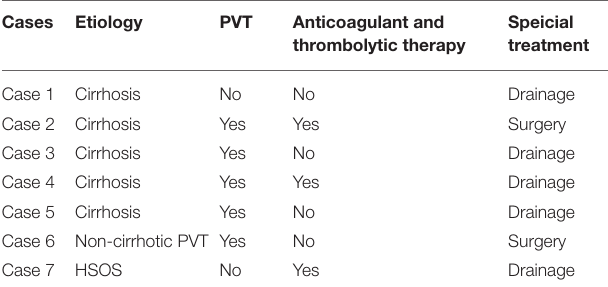
TABLE 3 | Patients who had hemoperitoneum. Cases